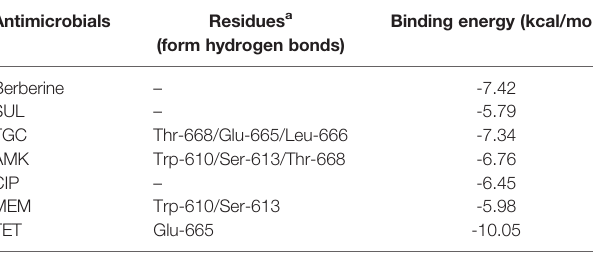
TABLE 2 | Binding energy of protein-ligand docking models. Antimicrobials